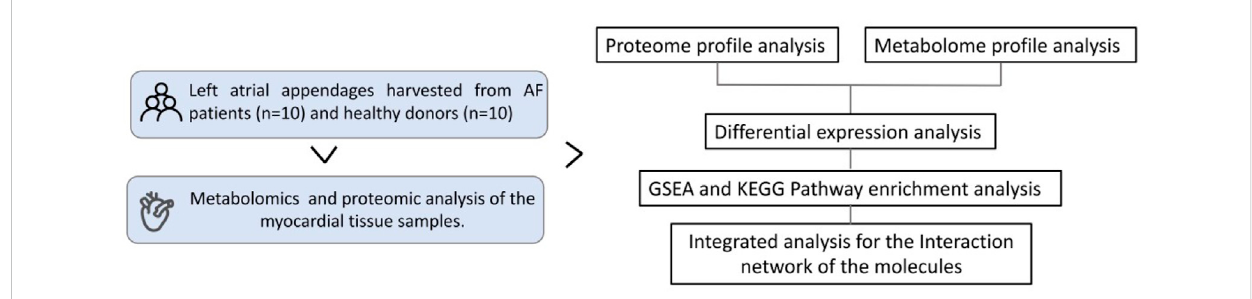
FIGURE 1 Study fl owchart.